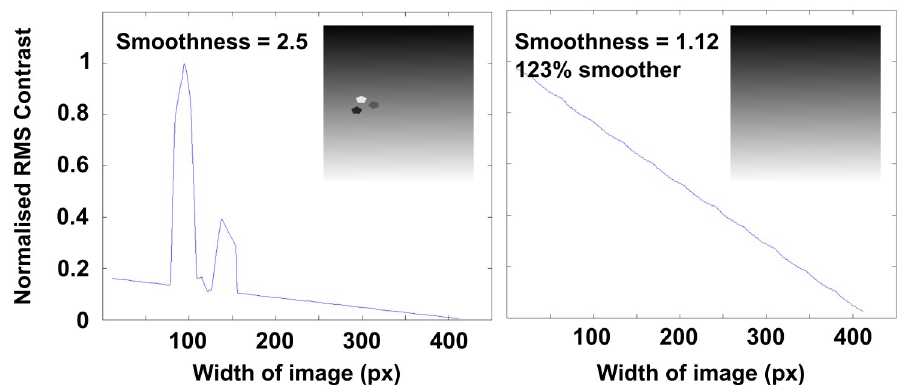
Fig 4. Model of a ‘non-smooth’ and ‘smooth’ retinotopic map, with RMS contrast plots and a corresponding ‘smoothness’ measure, based on the absolute gradient of the plotted